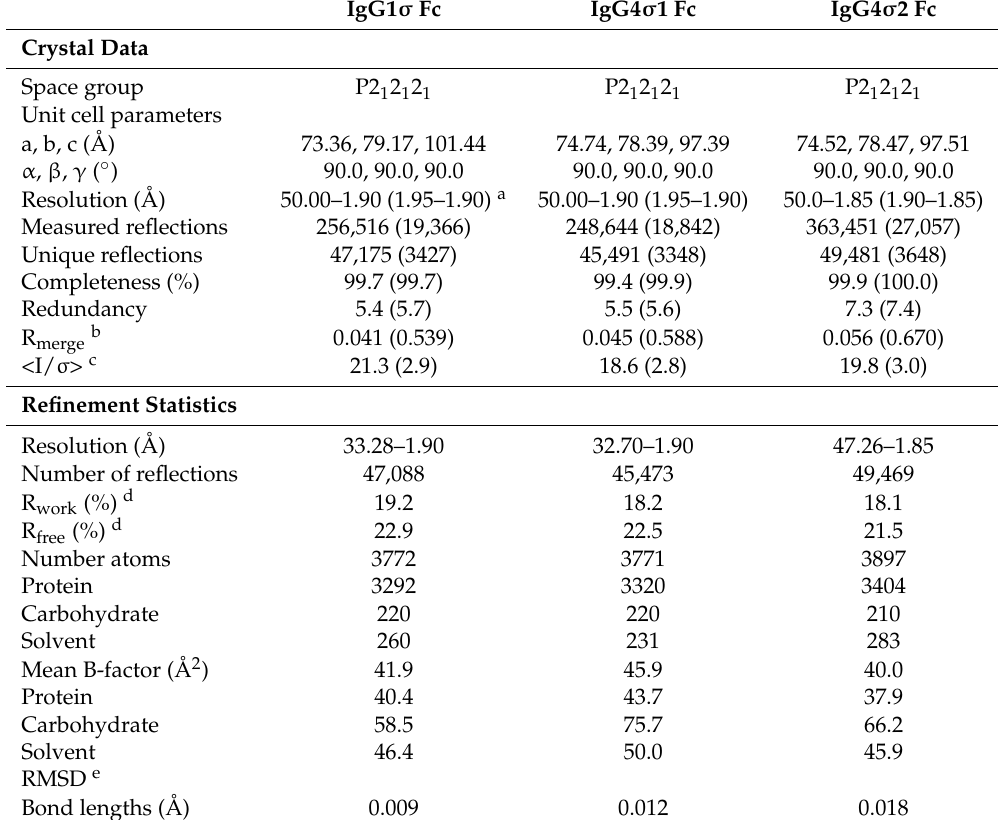
Table 7. X-ray crystallographic data and refinement